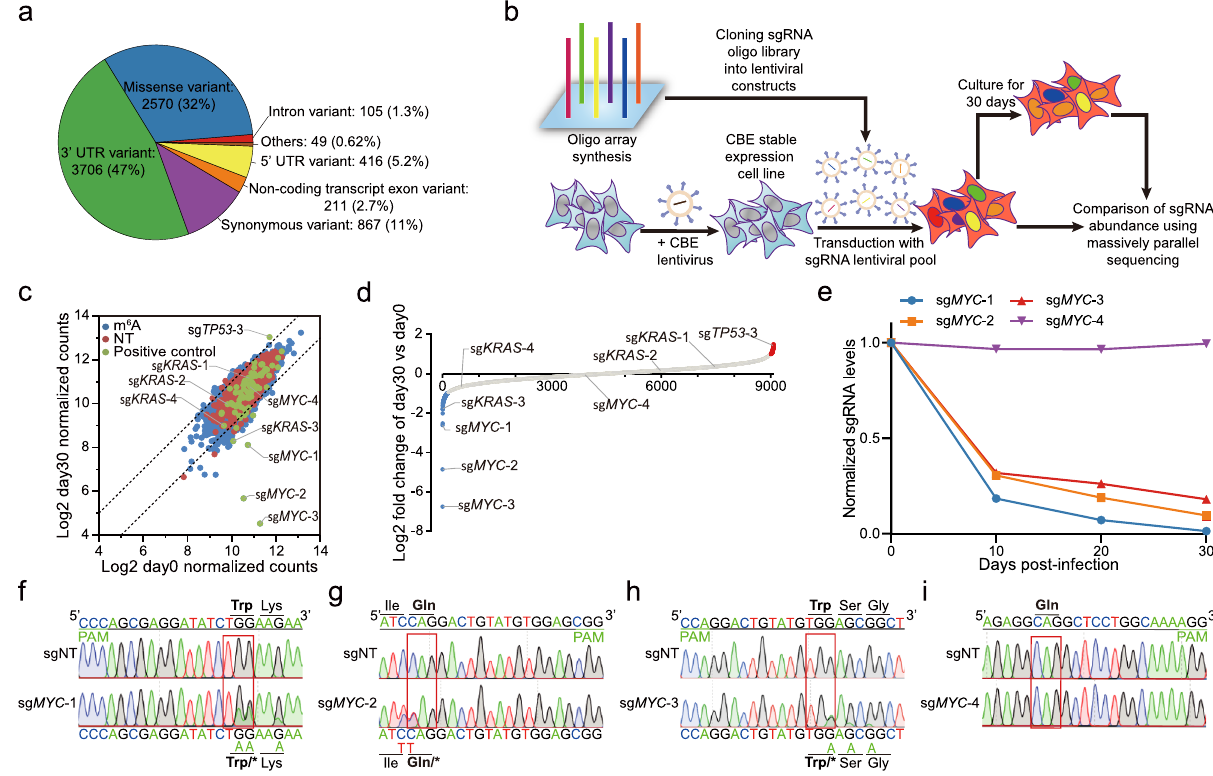
Fig. 2 FNLS-BE3 base editor-based screening in A549 cells. a Variant effect prediction of FNLS-ABE7.10(AW) base editor-induced mutations for targetable loci. b Schematic illustration depicting FNLS-BE3 base editor-based screening in A549 cells. c Scatter plot comparing the normalized sgRNA counts of day 0 and day 30 during FNLS-BE3 base editor-based screening in A549 cells. The dotted lines indicate log2-fold change (LFC) of 1 and − 1, respectively. d Dot plot showing the sorted LFCs of sgRNAs in FNLS-BE3 base editor-based screening in A549 cells. sgRNAs with LFC < − 1 or LFC > 1 were colored in blue or red, respectively. e Relative abundances of MYC targeting sgRNAs predicted to induce BE3-mediated CRISPR-STOP during the expansion of A549 cells ( n = 2 biologically independent samples). Data are presented as means. f – i Representative sequence chromatogram of FNLS-BE3-treated A549 cells at MYC -1 ( f ), MYC -2 ( g ), MYC -3 ( h ), and MYC -4 ( i ) loci. Source data are provided as a Source Data fi le. NATURE COMMUNICATIONS| (2022) 13:478